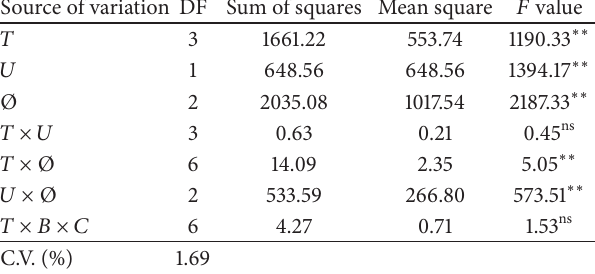
Table 1: Analysis of variance for the maximum yield of Jatropha oil extracted (%) at different temperatures ( 𝑇 ), moisture contents ( 𝑈 ), and average particle sizes